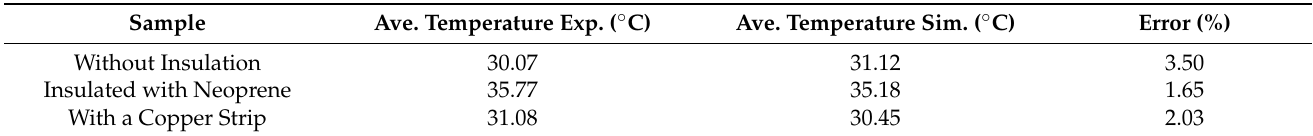
Table 5. Results from heating test for the rolled sample.